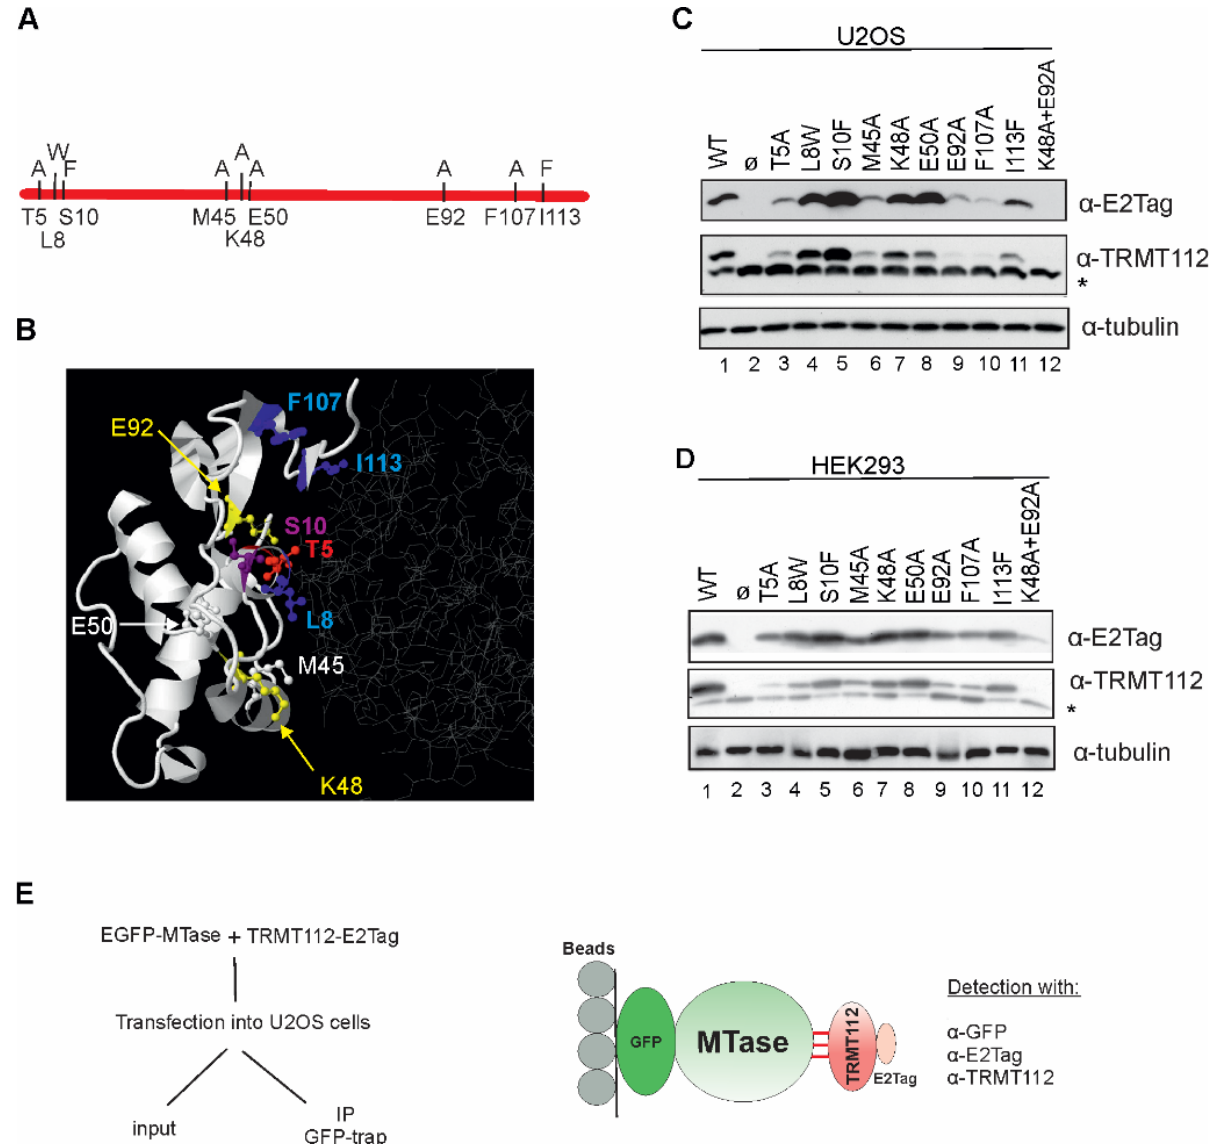
Figure 4. TRMT112 expression and stability is affected by single amino acid mutations. ( A ) Schematic view of point- mutations made in this study. Original amino acids are shown under the line and mutations on the line. ( B ) Localisation of point-mutations on the crystal structure of METTL5-TRMT112 complex (PDB code 6H2U). The structure is visualised with Jmol (http://www.jmol.org/; August 2021), where TRMT112 is depicted in white ribbon mode and METTL5 in grey wireframe. Mutated amino acids are shown as coloured ball and stick structures. ( C ) U2OS and ( D ) HEK293 cells were transfected with plasmids encoding for E2Tagged WT TRMT112 (line 1) and TRMT112 containing single amino acid mutations (lanes 3–12) and an empty vector (lane 2). Cells were analysed 48 h later using antibodies against E2Tag, TRMT112 and tubulin. Images of results with anti-TRMT112 depict both recombinant (upper band) and endogenous (lower band marked with asterisk *) protein. ( E ) Experimental scheme of the co-immunoprecipitation assay used in this study.